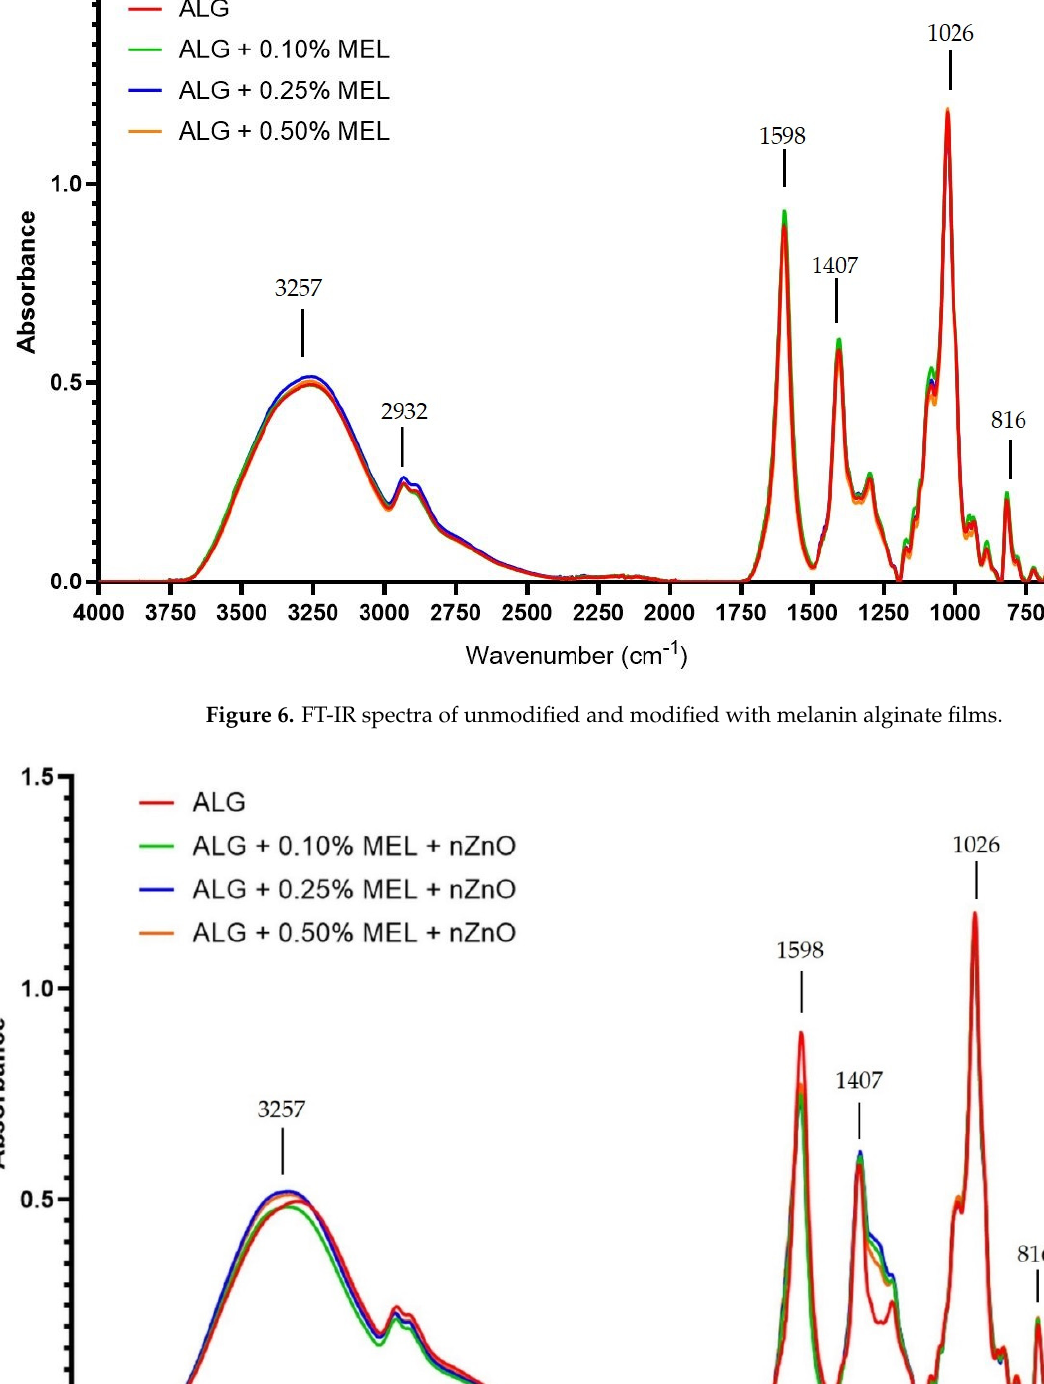
Figure 8. FT-IR spectra of unmodified and modified with melanin and silver nanoparticles alginate films.